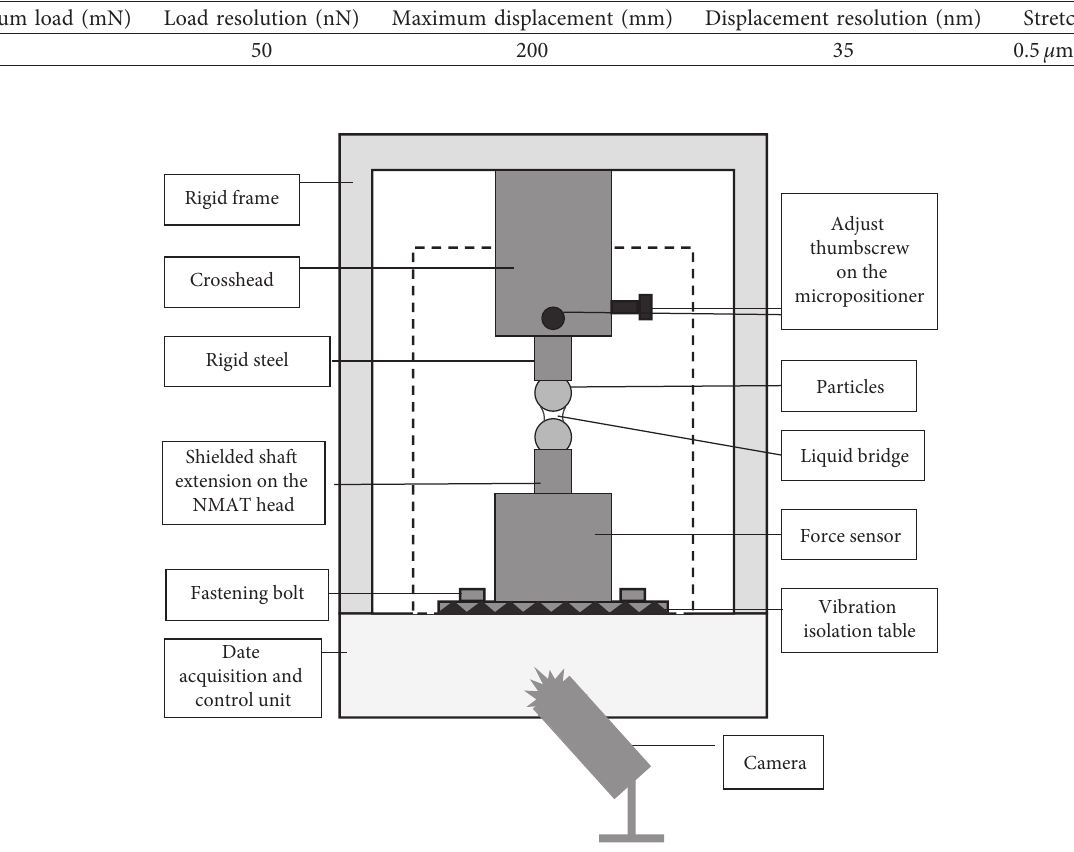
Figure 1: Schematic of the UTM T150 system experimental